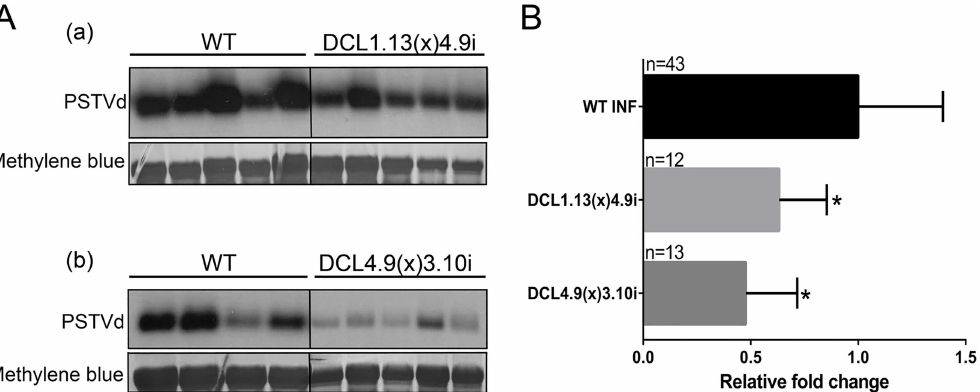
Fig 5. PSTVd infectivity in DCL1.13(x)4.9i and DCL4.9(x)3.10i plants. (A) Representative northern blots of DCL1.13(x)4.9i and DC4.9(x)3.10i PSTVd infected plants at 3wpi. Hybridizations were performed with DIG